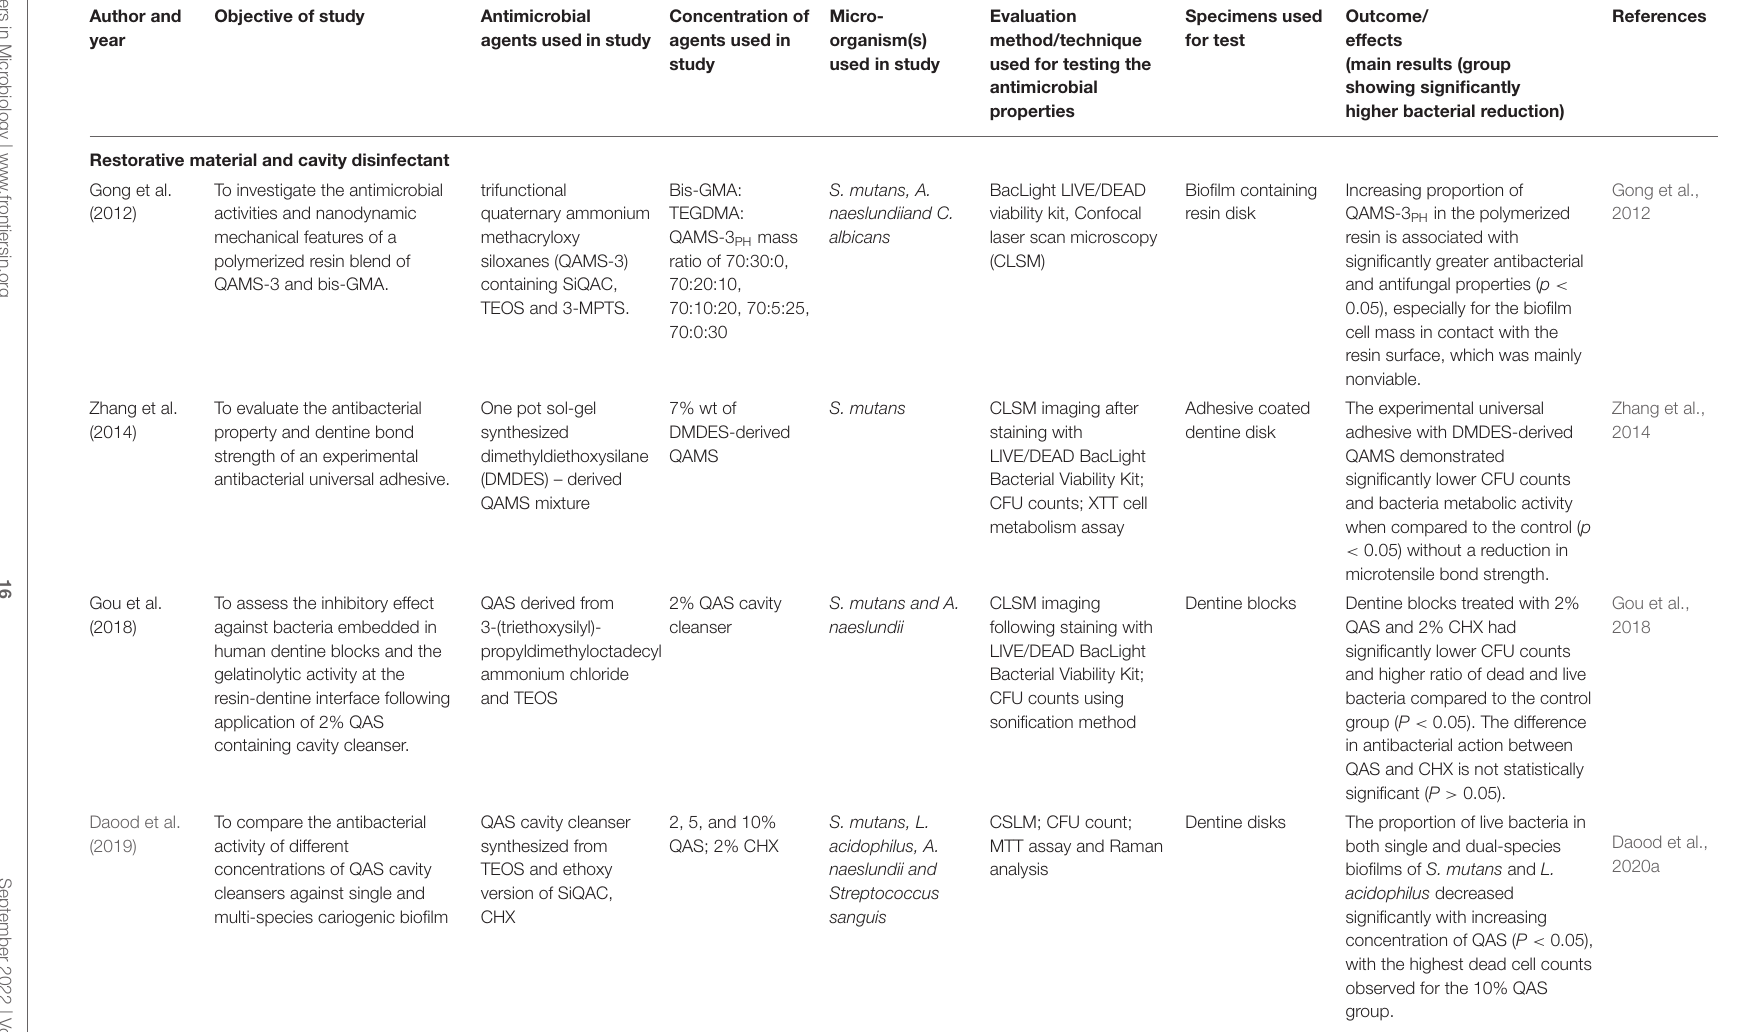
TABLE 1 | Studies showing research on antibacterial potential of QAS as restorative material, cavity disinfectant, root canal medicament, nano-drug